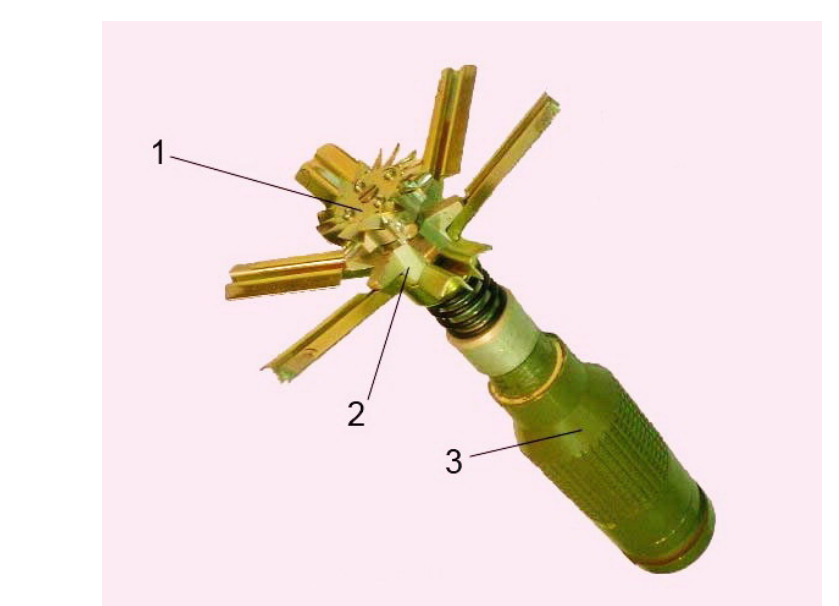
Рис . 2 – Тестовая модель ПТАБ ( внешний вид ): 1 – крыльчатка с центребрежными предохранителями , 2 – стабилизатор со складывающимися лопастями , корпус бомбы Figure 2 – PTAB Test Model (exterior sideview): 1 – arming vane with centrifugal safety pins, 2 – stabilizer tail unit with folding fins, 3 – bomb